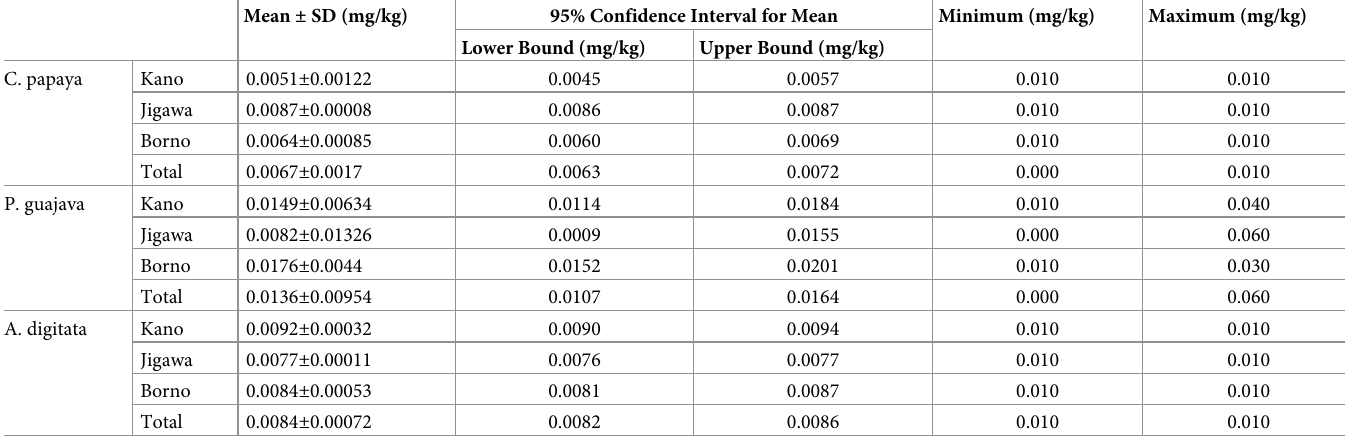
Table 4. Descriptive statistics of the activity concentration of Cd in the medicinal plants from the three states. Mean ± SD (mg/kg) 95% Confidence Interval for